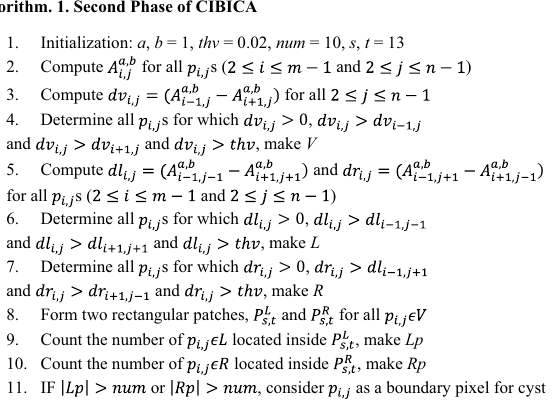
P R s , t around p i,j . The values of s and t are 4 and 3,